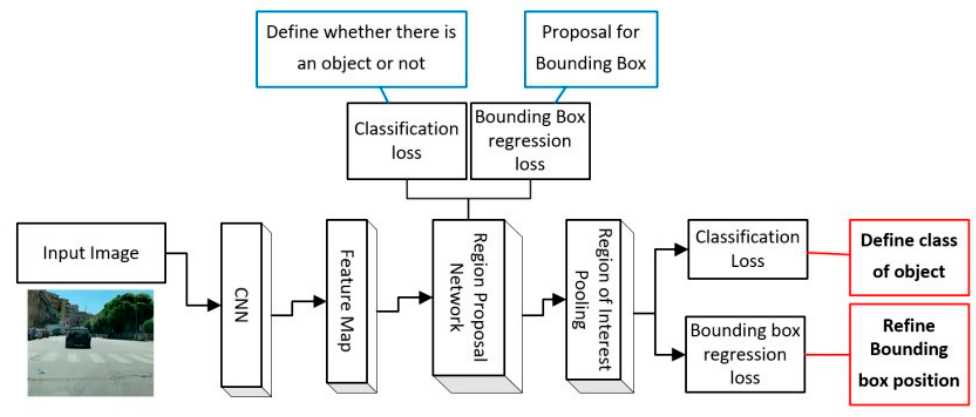
Figure 9. The architecture of Faster R-CNN model.